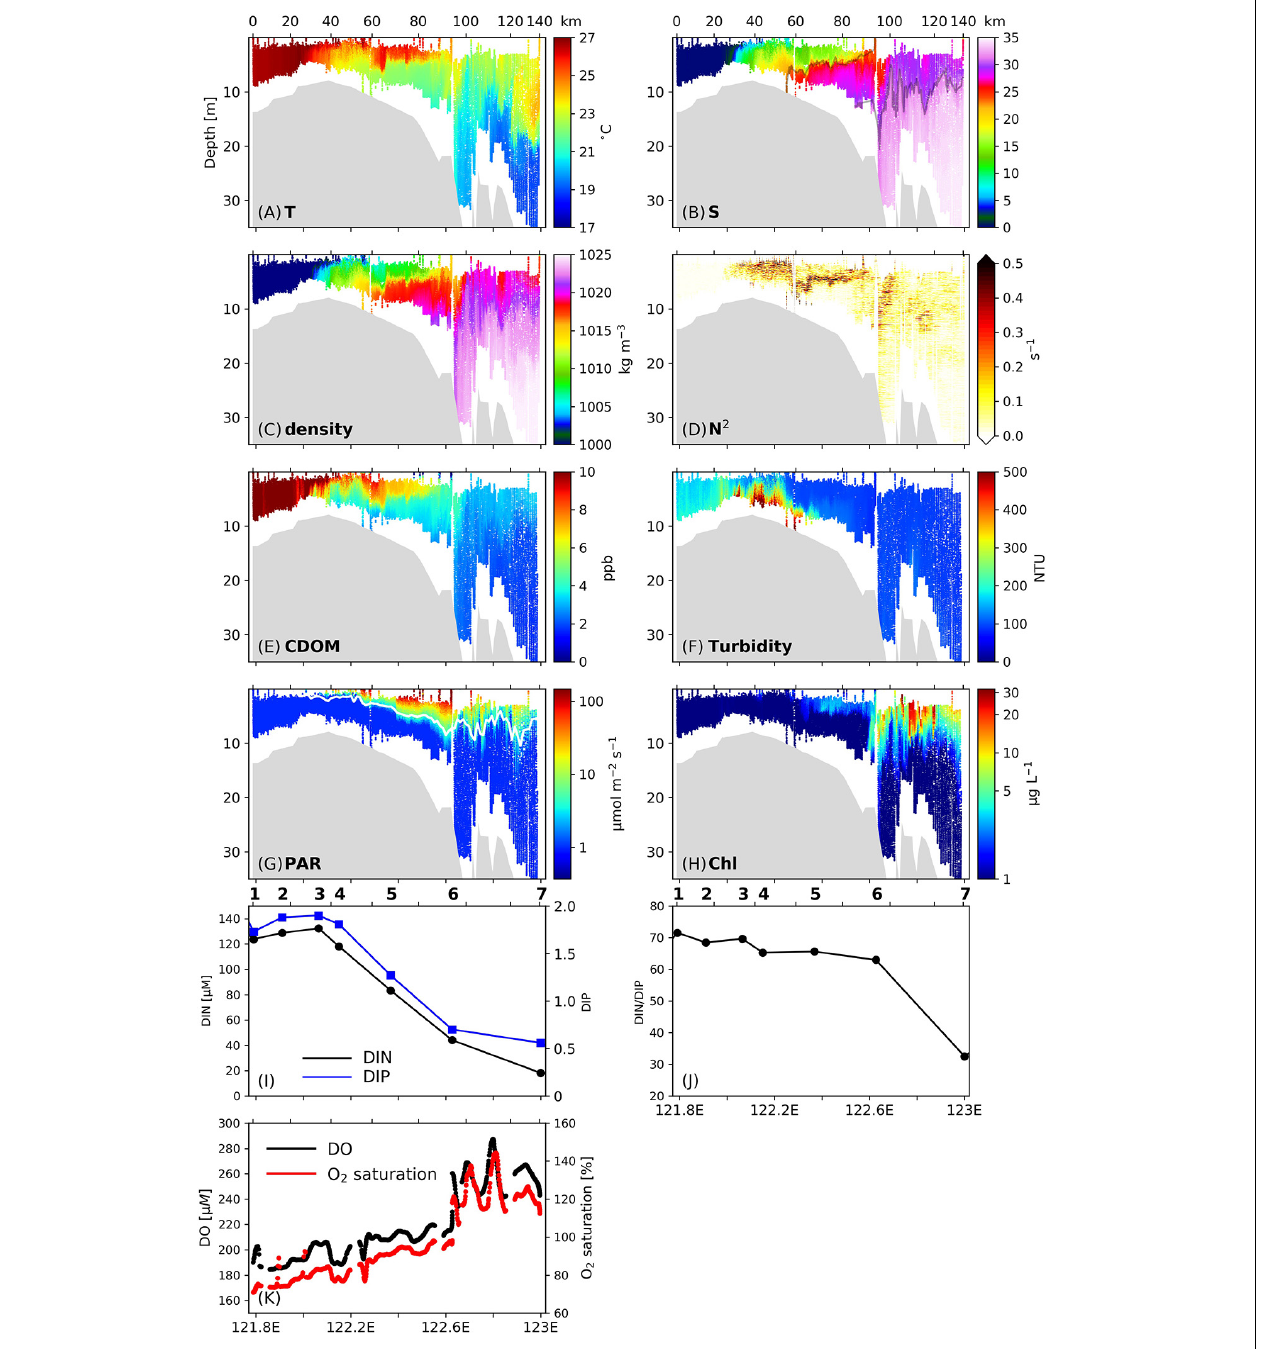
FIGURE 2 | (A–G) Vertical profiles of (A) temperature, (B) salinity, (C) density, (D) stratification frequency ( N 2 ), (E) CDOM concentrations, (F) turbidity, (G) PAR, and (H) Chl concentrations along Transect C1 surveyed on 3 July 2017. Numbers on the upper x -axis denotes the distance (unit: km) from the inshore boundary of the transect. Isohalines of 23 and 31 are denoted by the gray lines in (B) . The white line in (G) denotes the euphotic layer depth. (I) Surface DIN (black line) and DIP (blue line) concentrations along C1. (J) Surface ratio of DIN to DIP along C1. (K) Surface dissolved oxygen (DO) concentrations (black dots) and oxygen saturation (red dots) along C1. Stations are labeled on top of (I,J)